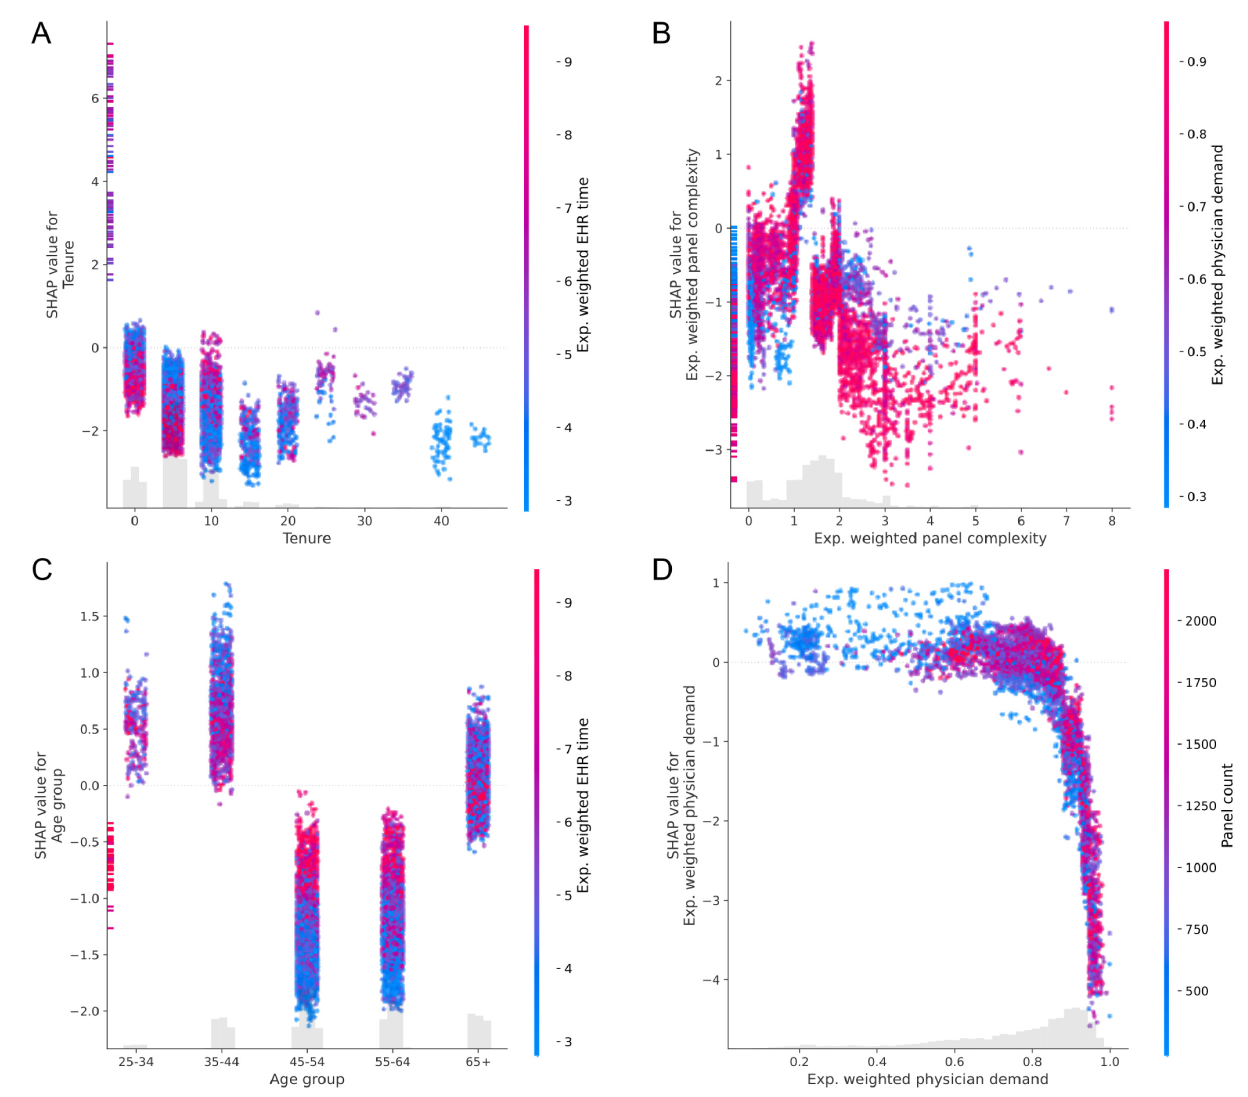
Fig 3. Dependence plots for the features with greatest average absolute SHAP values. Feature value is displayed on the x -axis and the associated SHAP value is displayed on the y -axis. SHAP values greater than zero denote an increase in risk. Color shows the value of the secondary feature estimated to have the strongest interaction with the primary